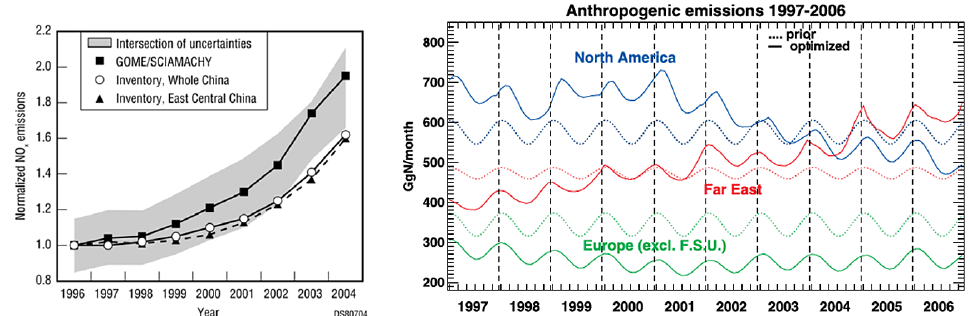
Figure 23. Temporal evolution of NO x emissions over China from the Zhang et al. (2007) inventory (left panel) and inverse method using satellite observations (right panel). All data are normalised to the year 1996 (Zhang et al., 2007).